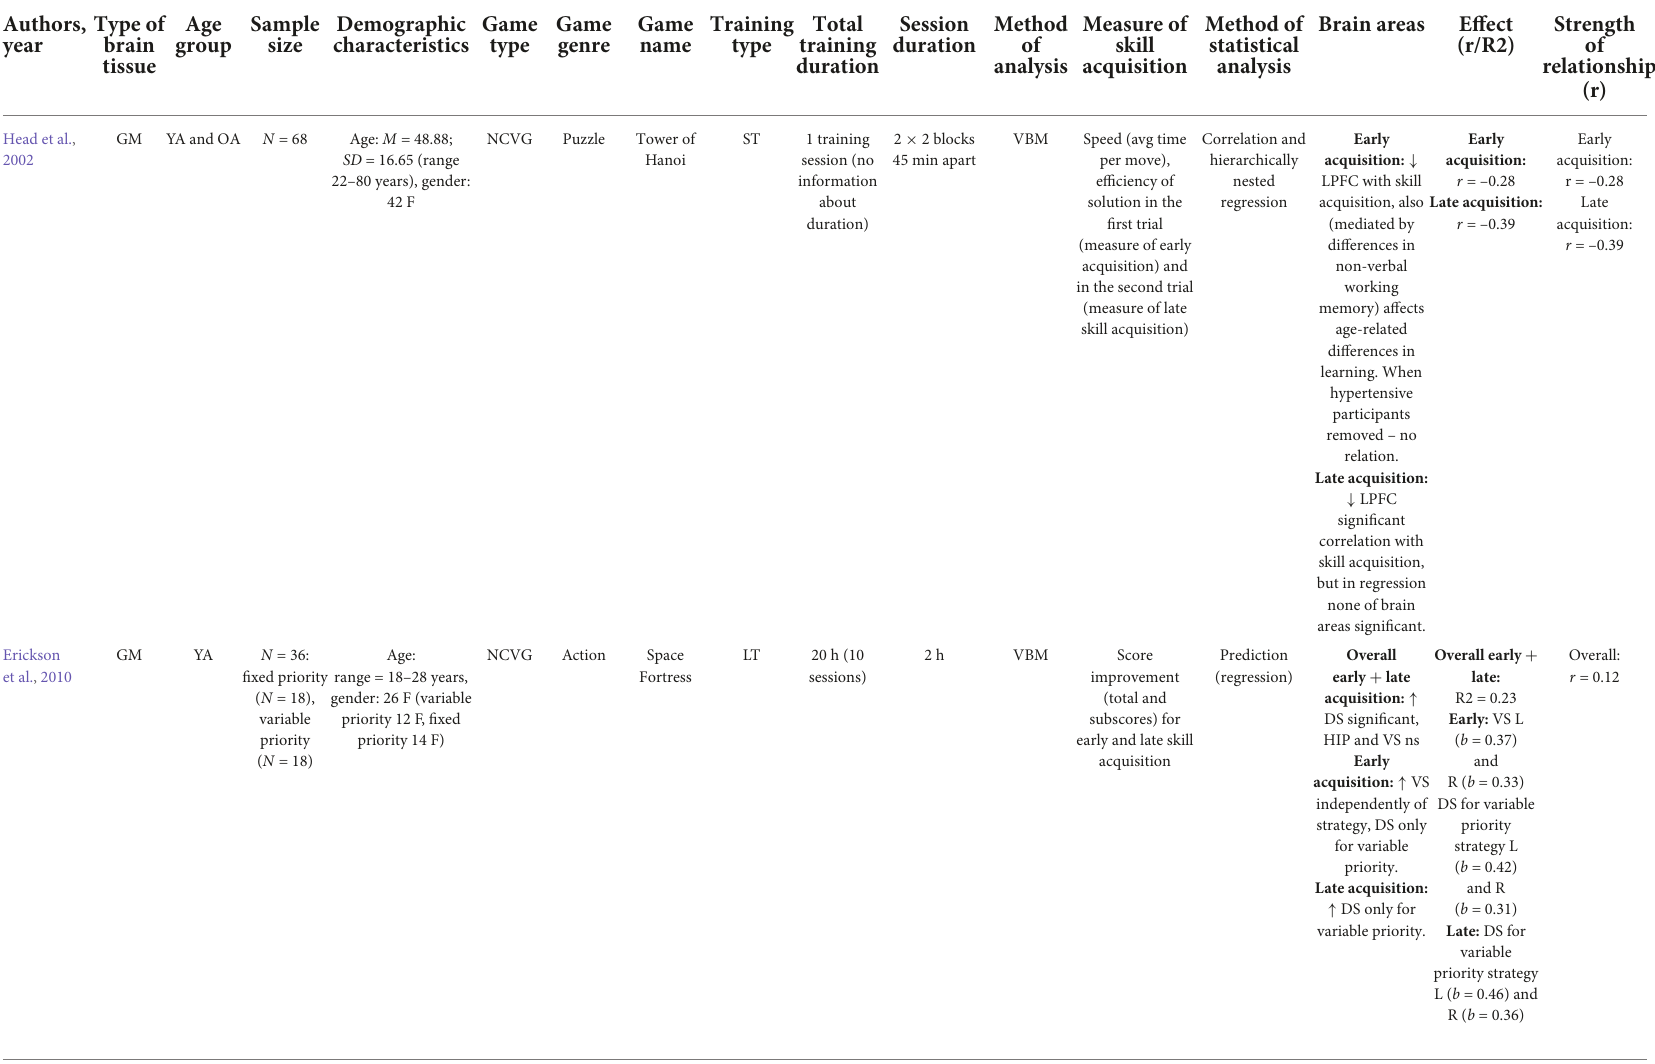
TABLE 1 Summary of studies of structural predictors of skill enhancement in VG complex task